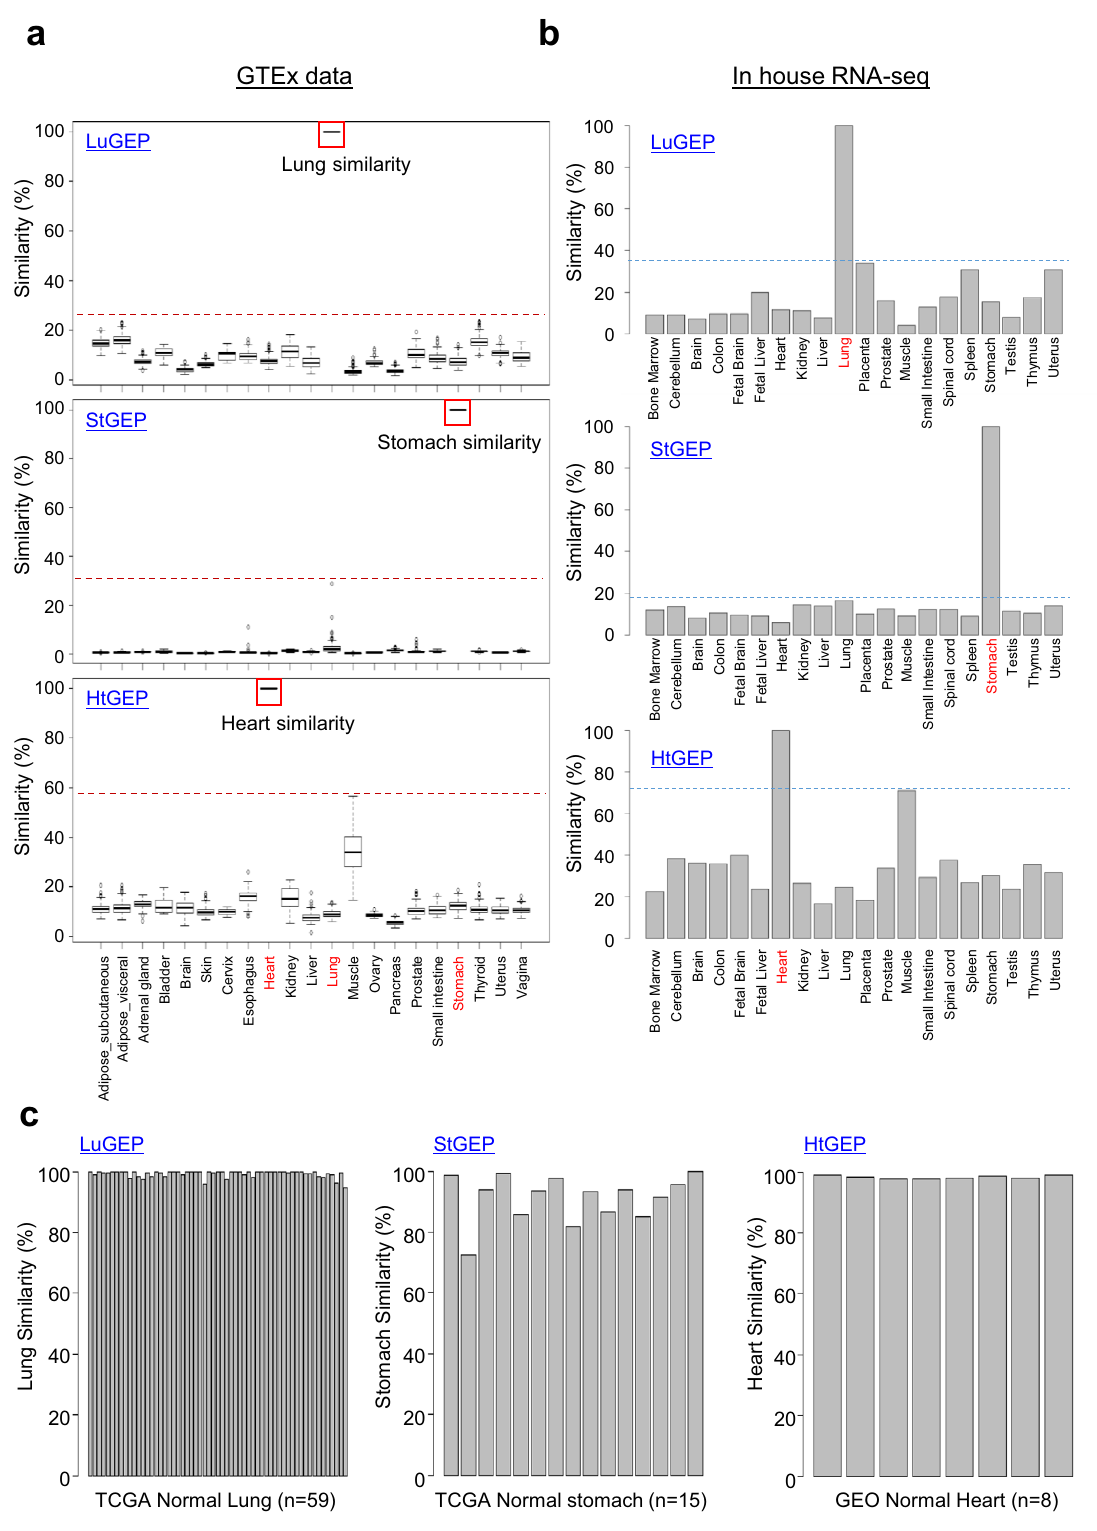
Fig. 2 Development and evaluation of the Organ-GEP algorithm. a Distribution of the Organ-GEP algorithm (LuGEP, StGEP, HtGEP) scores. RNA-seq data were downloaded from the GTEx portal. A box plot shows the interquartile (IQR) range of each algorithm score in 21 tissue types. The boxes denote the lower (Q1) and upper (Q3) quartiles, and the center line is the median. The whiskers represent the highest and lowest values that are not outliers or extreme values. Circles beyond the whiskers represent outliers and extreme values. The GTEx tissues of each Organ-GEP, i.e., lungs of LuGEP, have 100% similarity scores. b Validation of the Organ-GEP algorithm using in-house data (20 tissue samples). Pooled RNA-seq data of each tissue were purchased from Clontech. c Validation of the Organ-GEP algorithm with TCGA and GEO data. The organ similarity scores of live samples for LuGEP, StGEP, and